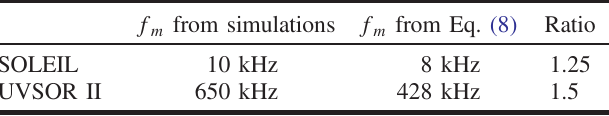
TABLE II. Value of the modulation frequency f m of the THz signal obtained from numerical simulations and with Eq.